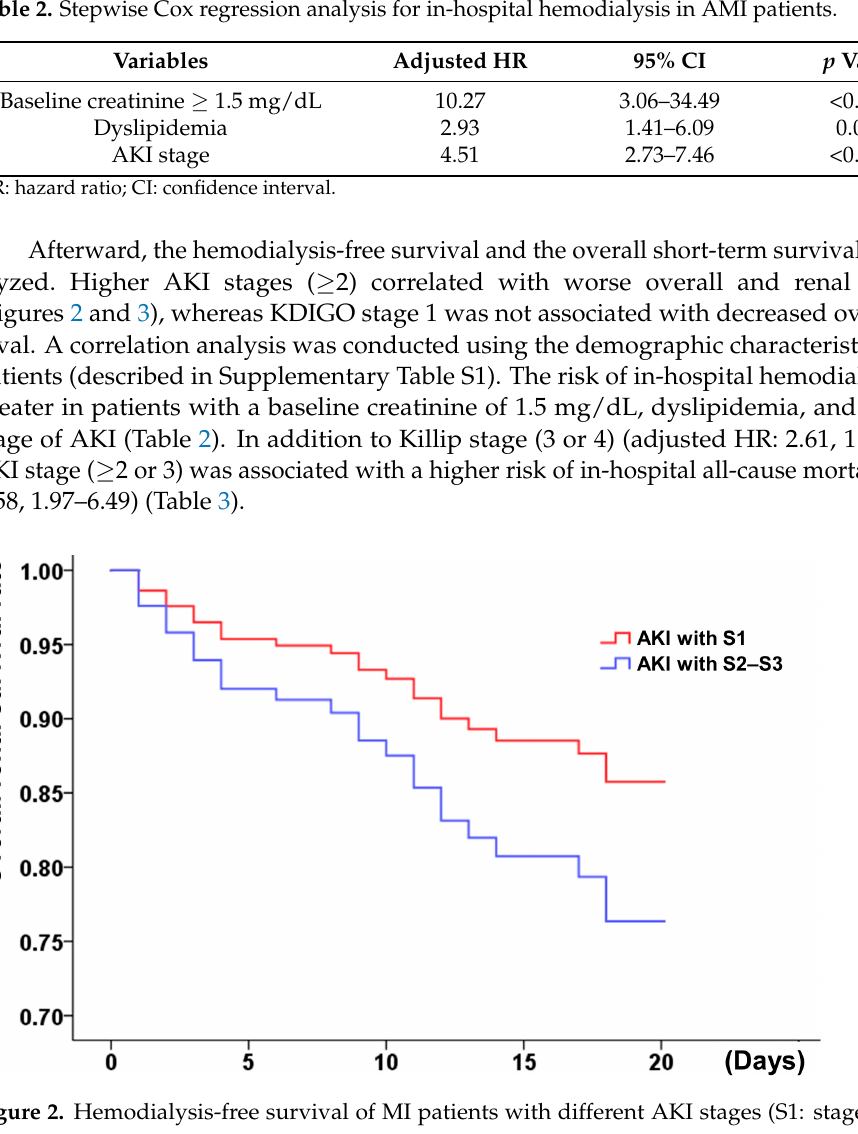
Table 2. Stepwise Cox regression analysis for in-hospital hemodialysis in AMI patients. Variables Adjusted HR 95% CI p Value Baseline creatinine ≥ 1.5 mg/dL